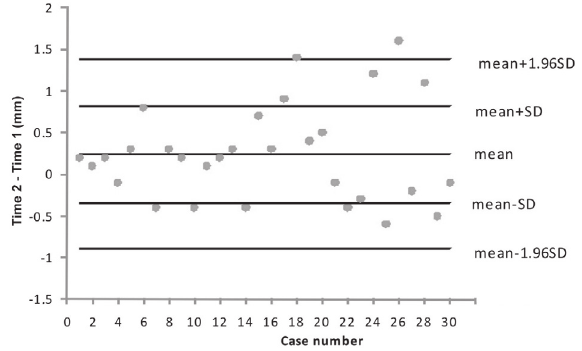
Figure 2- Double readings of models with the line of equality